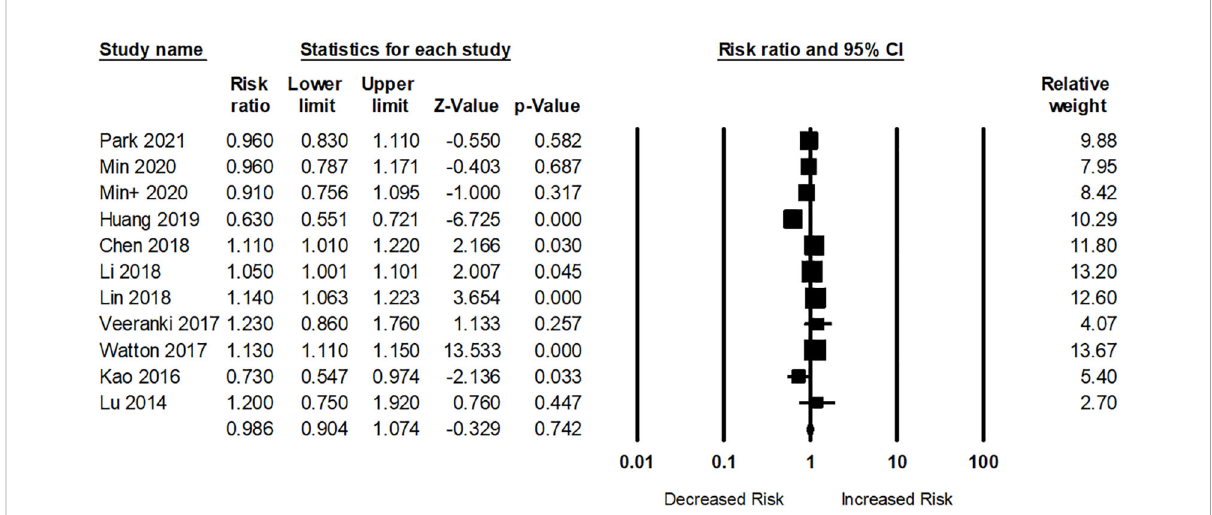
FIGURE 5 Association between rheumatoid arthritis (RA) and dementia risk. + indicates that the same author has 2 studies.